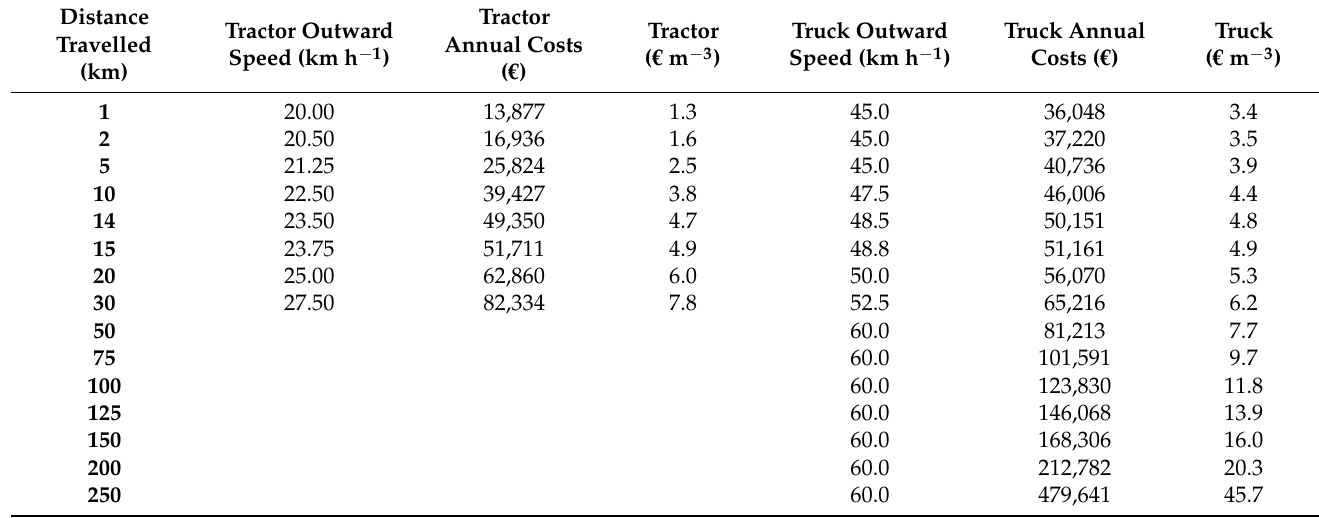
Table 3. Annual costs associated with raw pig manure transport and spreading by tractor and vacuum tanker and by truck for a 500-sow integrated pig farm (reproduced by permission from Nolan et al. 2012 [70]).